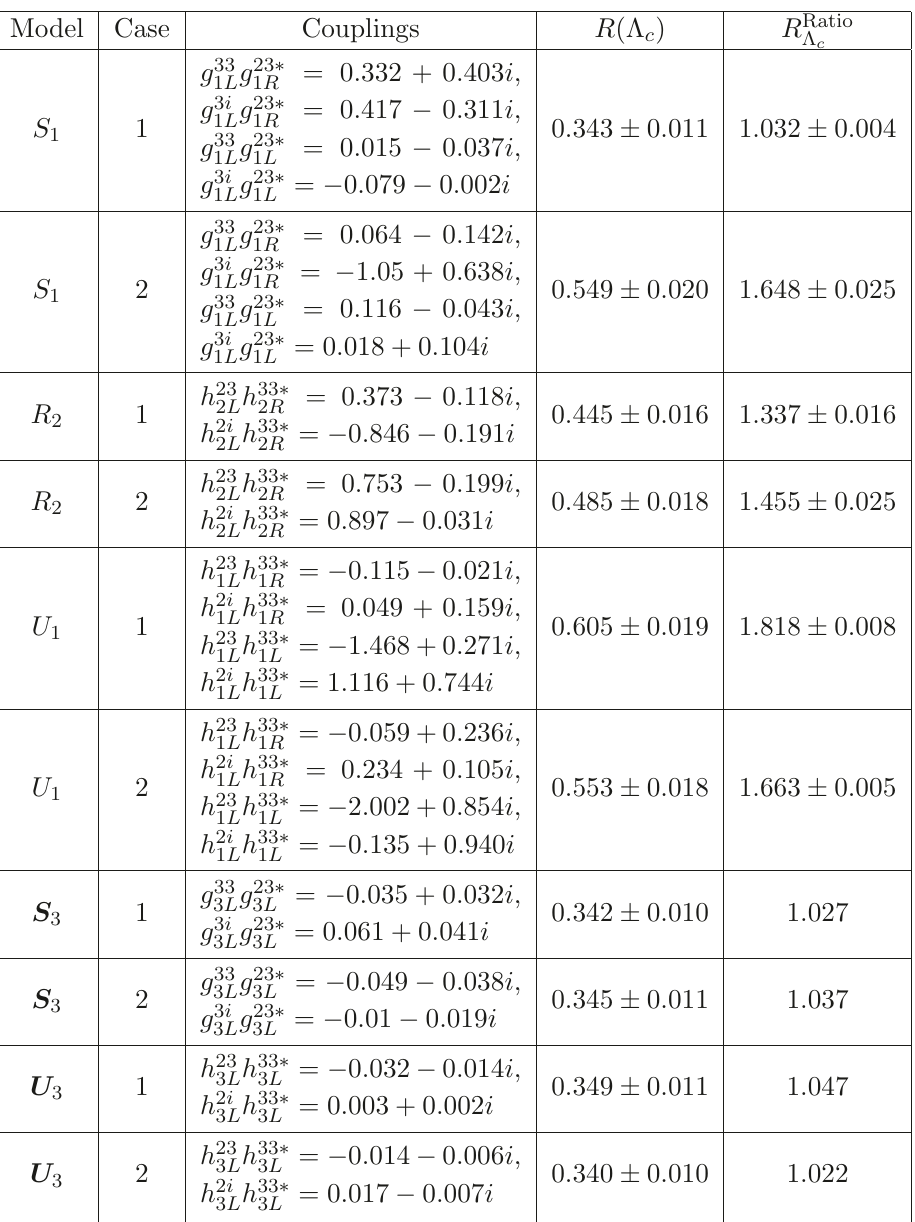
Table 6 . The values of the R (Λ c ) and R Ratio ratios for two representative cases of the couplings of Λ c the different leptoquark models. Above, the index i = 1 , 2 denotes the electron and muon neutrinos. The Standard-model value of the ratio is R (Λ c ) = 0 . 333 0 . 010 [48]. The uncertainties given are ± due to the Λ b Λ c form factor →